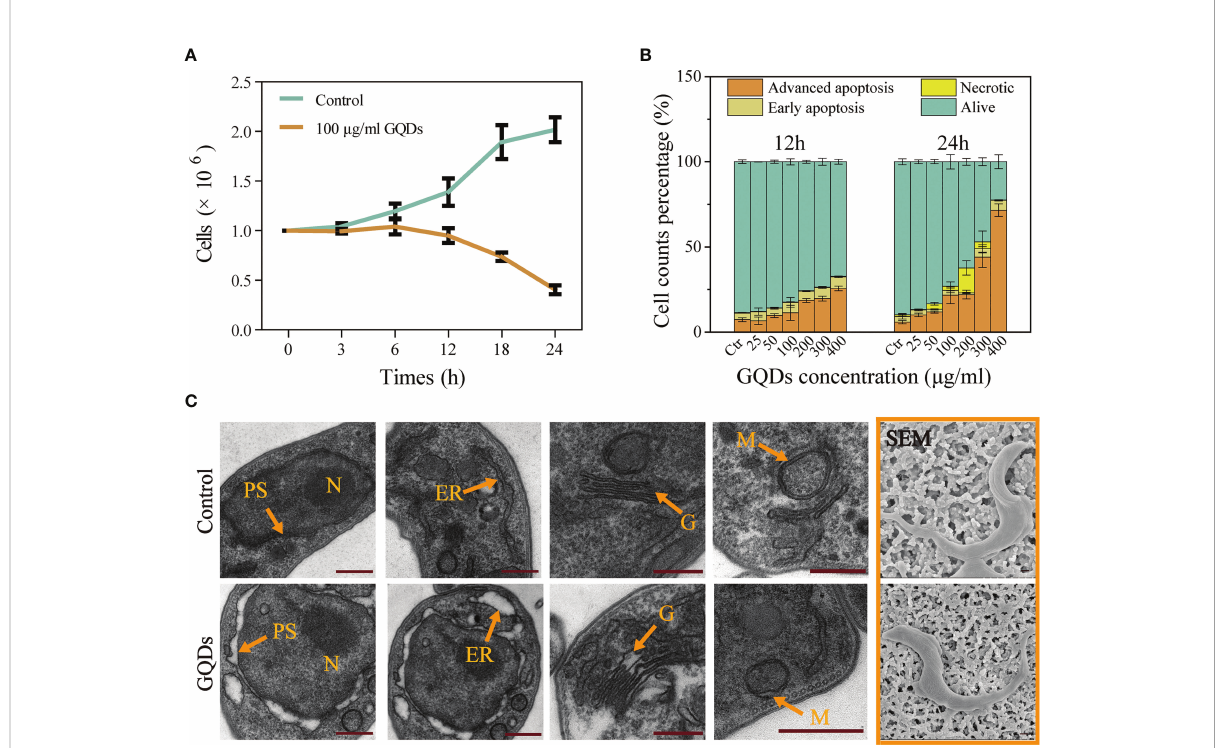
FIGURE 2 Growth curves and subcellular organelle pathophysiological changes in Trypanosoma brucei following treatment with graphene quantum dots (GQDs). (A) Growth curves based on nuclear counts of T. brucei after treatment with GQDs for 24 h. T. brucei that did not receive GQDs treatment were used as controls. (B) Apoptosis of T. brucei induced by GQDs at 12 and 24 h. The parasites primarily displayed advanced apoptosis after treatment. Statistical studies were performed based on the fl ow cytometry data in Supplementary Figure S6. Early apoptosis was manifested as green fl uorescence in combination with annexin V-FITC. Necrosis was manifested as no change in membrane permeability, while nuclei showed red fl uorescence in combination with the fl uorescent dye propidium iodide. Cells stained with two dyes were considered to be in the advanced apoptosis stage. (C) TEM and SEM images of T. brucei captured after cultivation with GQDs (50 m g/ml) for 24 h. Orange arrows indicate organelles. N , nuclei; ER , endoplasmic reticulum; G , Golgi apparatus; M , mitochondria; PS , perinuclear space. T. brucei parasites that were not exposed to GQDs were taken as controls. Scale bar , 500 nm. All values are the mean ± SD of triplicates. Student ’ s t -test was used to calculate the p -values. * p < 0.05, ** p < 0.01, *** p < 0.001 (compared to the